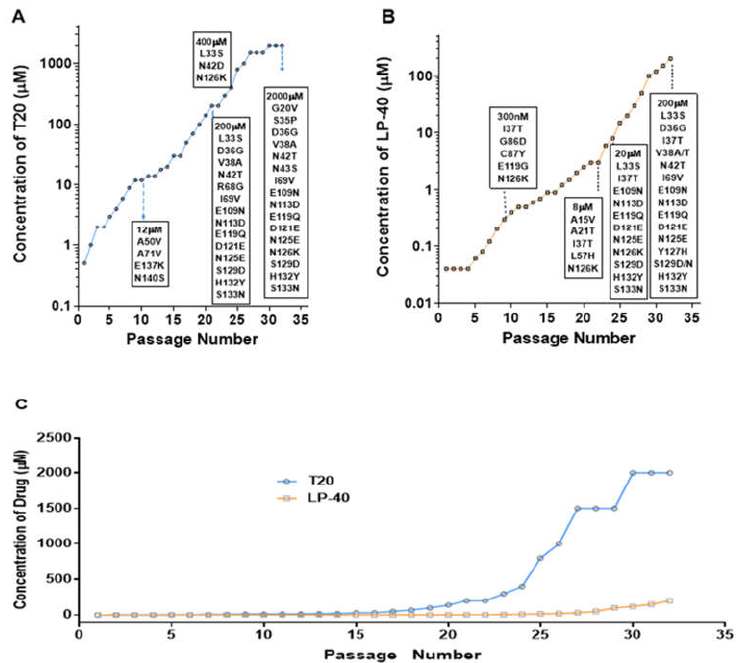
Figure 2. Introduction of T20- and LP40-resistant HIV-1. ( A ) The dose-escalating selections were conducted for a total of 32 passages, with T20 concentrations ranging from 500 nM to 2000 µM, and ( B ) for 32 passages, with LP40 concentrations ranging from 40 nM to 200 µM. At the indicated passage number, viral RNA was extracted from the supernatant, and gp41- and gp120-coding re- gions were sequenced. The mutations of gp41 are listed in the black frames. ( C ) HIV-1 NL4-3 was passaged in the presence of an increasing concentration of the inhibitors in C8166 cells.